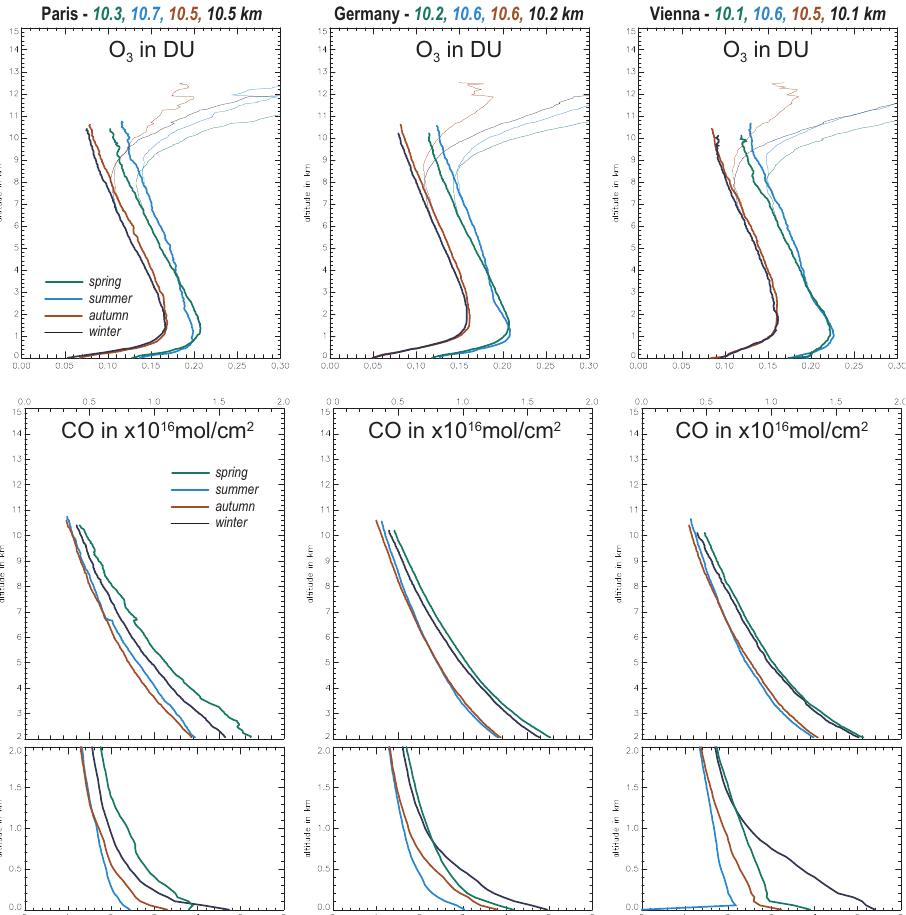
Fig. 10. Same as Fig. 8 but for Paris, Germany and